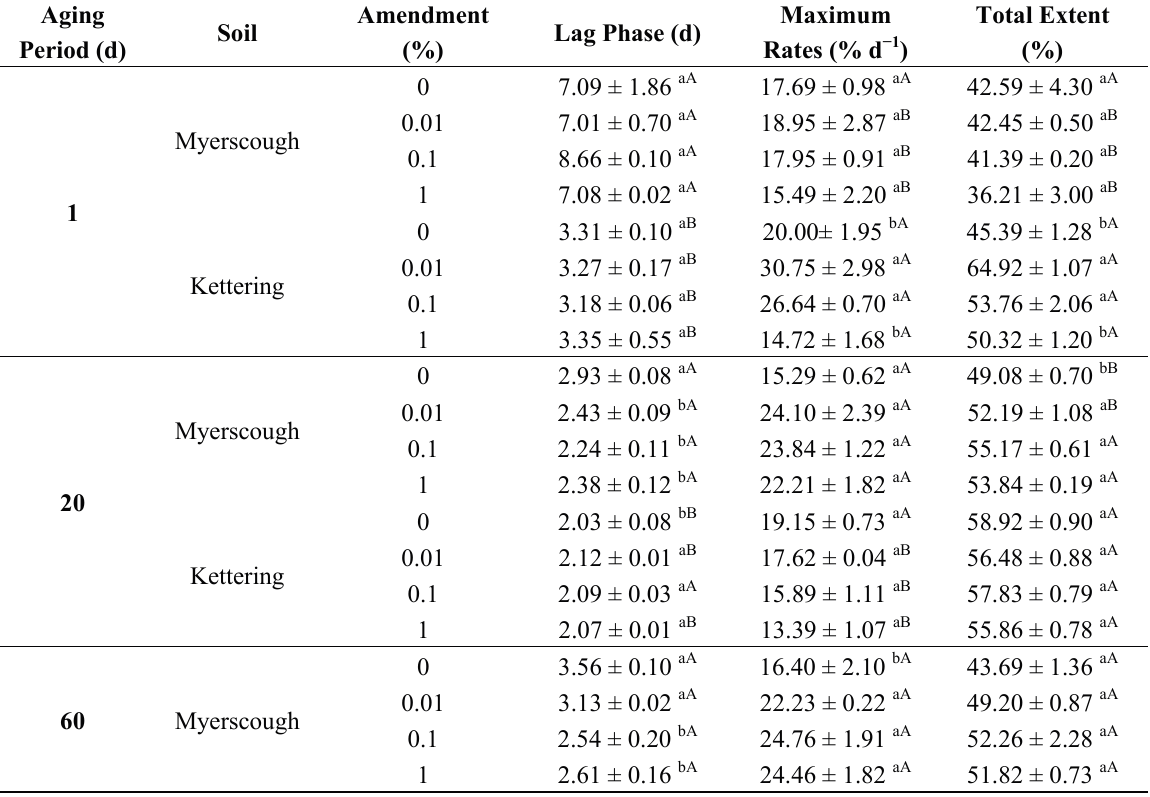
Table 4. Mineralisation of 14 C-phenanthrene in Myerscough and Kettering loam soils amended with 0%, 0.01%, 0.1% and 1% of 3–7 mm biochar. Errors represent standard error of mean (SEM) of triplicate samples ( n =